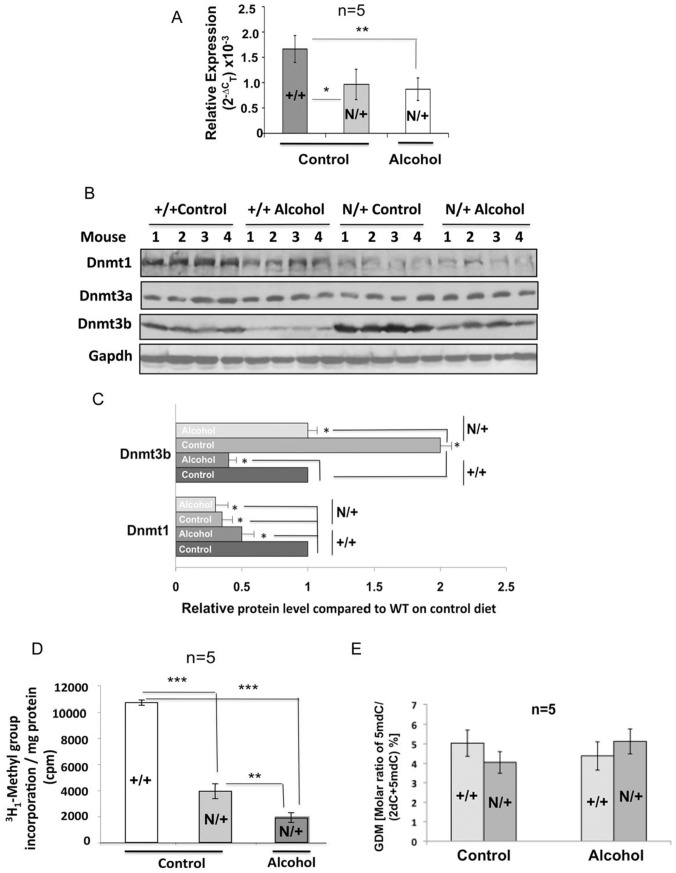

Dnmt1
N/+ mice exhibit reduced hepatic Dnmtase activity compared to the wild type mice fed control diet, which is further reduced upon feeding alcohol diet for 6 weeks.
A. qRT-PCR analysis of Dnmt1 in the livers of the wild type (+/+) and mutant (N/+) mice. B. Western blot analysis of Dnmt protein levels in the liver extracts of wild type and hypomorphic mice fed control or alcohol diet. C. Quantitative analysis of the western blot data in B by ImageJ software. Gapdh normalized signal of Dnmt1 and Dnmt3b in the wild type livers was assigned a value of 1. D. Dnmtase activity in the hypomorphic liver nuclear extracts was significantly reduced in alcohol fed mice. Dnmtase activity was measured as described in Fig. 1A. Single, double and triple asterisks represent P-values ≤0.05≤0.01 and ≤0.005, respectively. E Global DNA methylation (GDM) in the liver DNA was not altered in wild type and mutant mice fed alcohol diet. Briefly, genomic DNA from the liver was enzymatically hydrolyzed to nucleosides followed by LC-MS/MS analysis. GDM is represented as a ratio of 5-mdC to total cytosine. 5mdC and 2dC denote 5-methyl-2-deoxycytidine and 2-deoxycytidine, respectively.